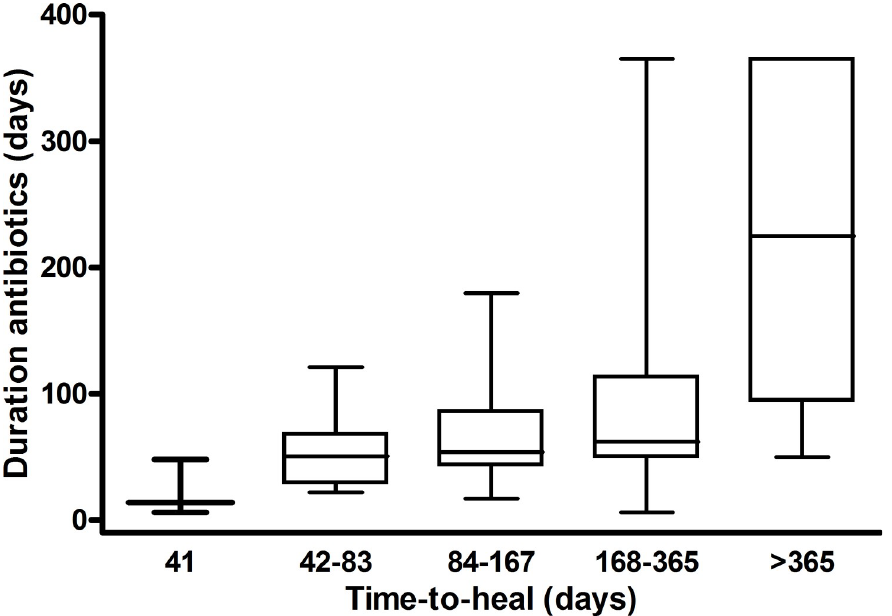
Fig 3. Association between time-to-heal of diabetic foot ulcers and duration of antibiotic treatment. Kruskal- Wallis p < 0.001.